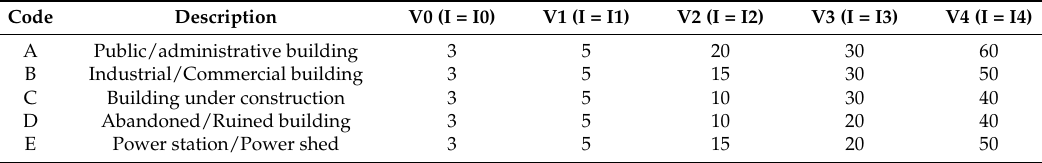
Table 4. Vulnerability values (V) in percent of each element at risk type for ground motions of different